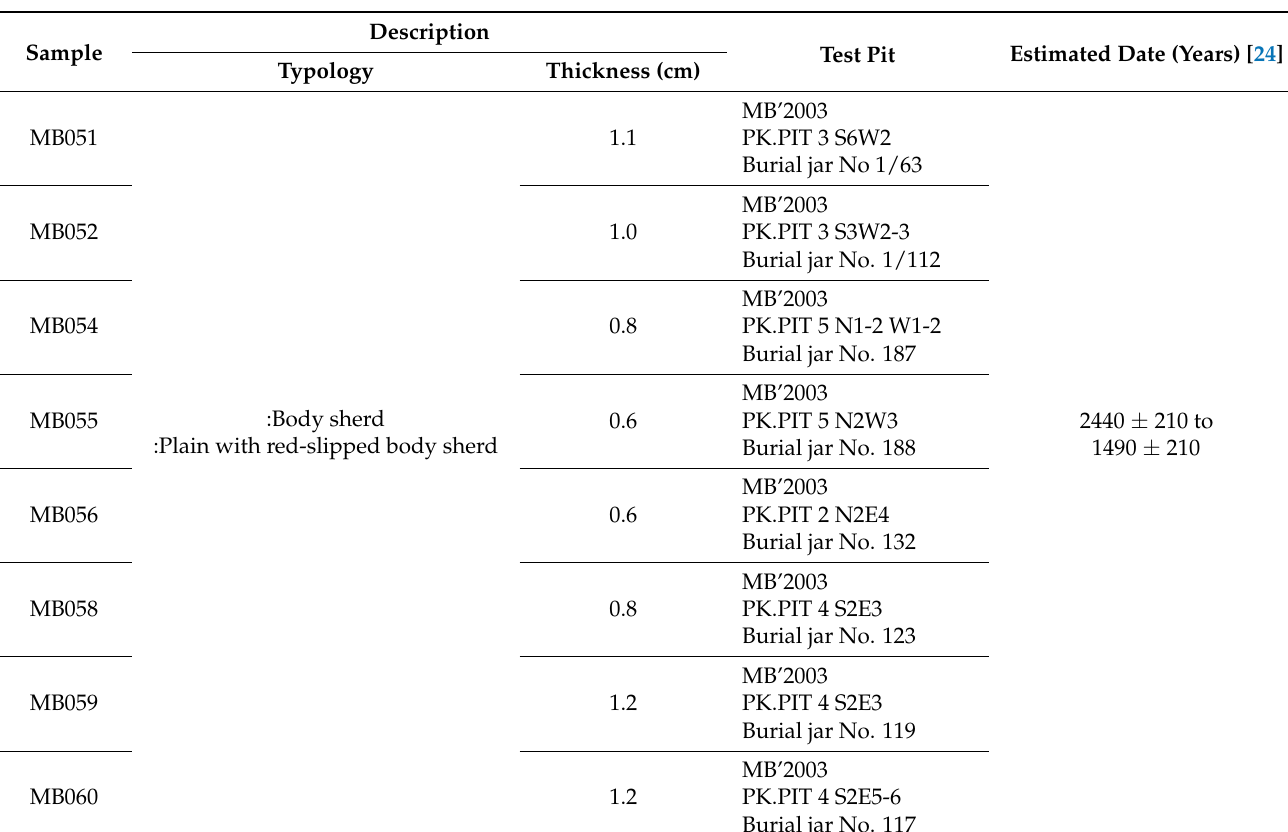
Table 1. Description of MB051, MB052, MB054, MB055, MB056, MB058, MB059, and